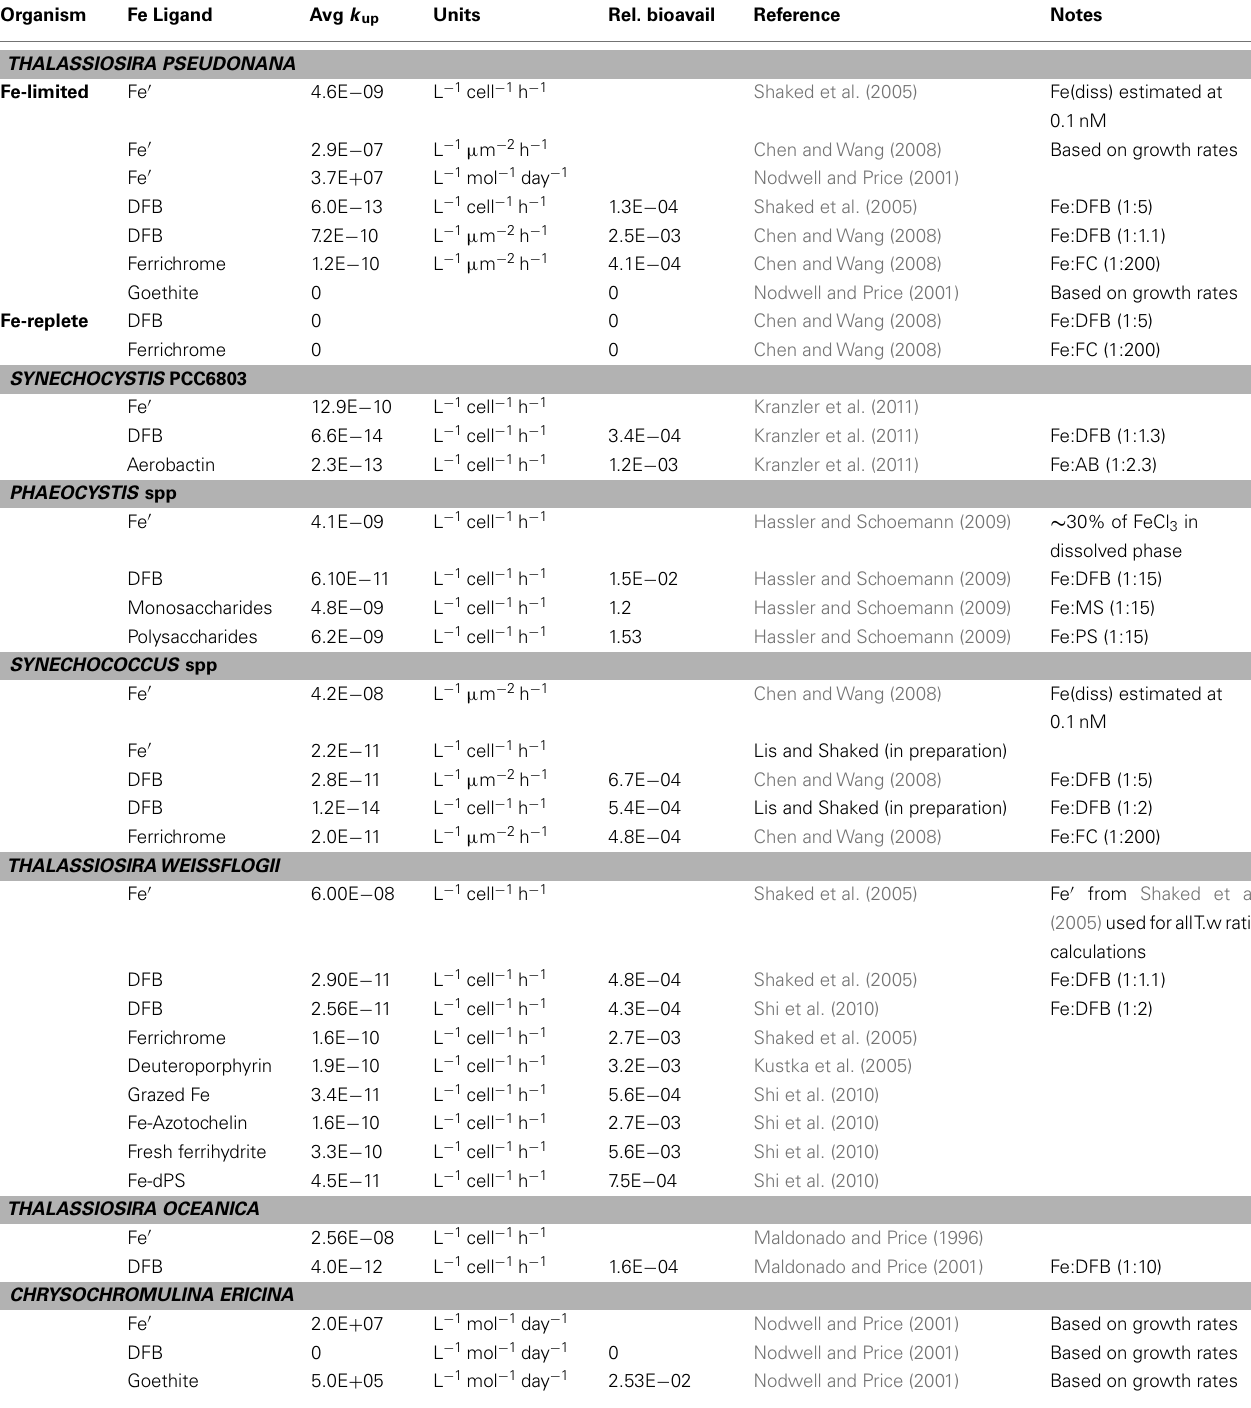
TableA3 | Data used in the calculation of relative bioavailability of laboratory cultures (Figure 5A). Organism Fe Ligand Avg k up Units Rel. bioavail THALASSIOSIRA